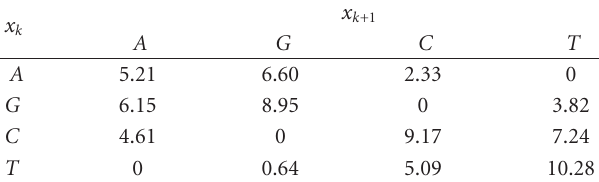
Table 9: Sample step